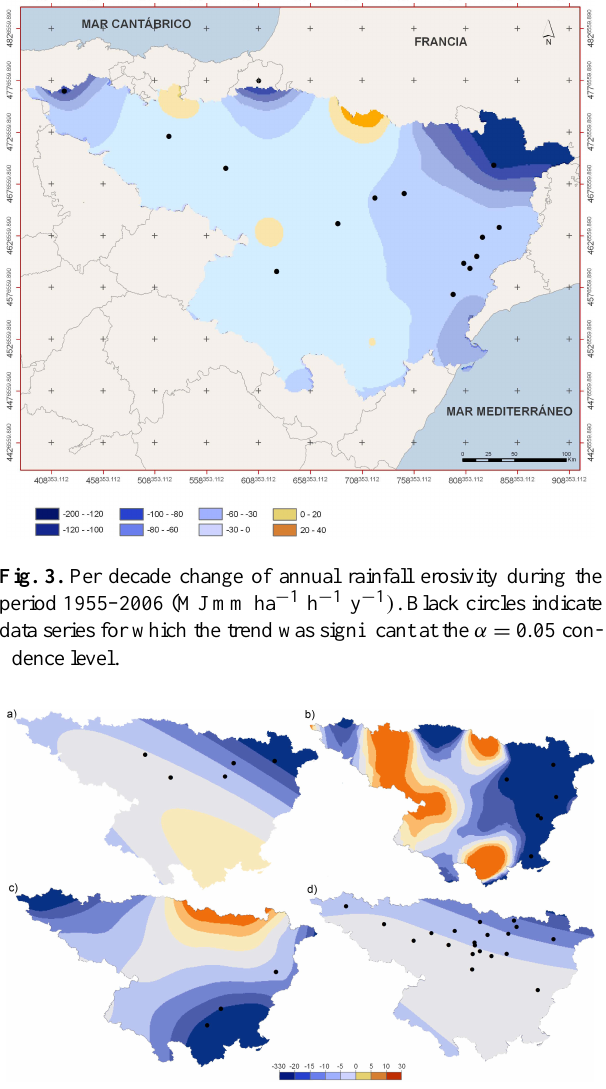
Fig. 4. Per decade change of seasonal rainfall erosivity during the period 1955–2006 (MJ mm ha − 1 h − 1 y − 1 ) : (a) DJF, (b) MAM, (c) JJA, (d) SON. Black circles indicate data series for which the trend was significant at the α = 0 . 05 confidence level.